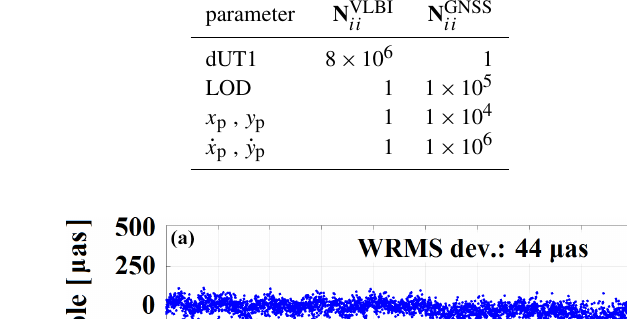
Table 4. Ratio N VLBI values in 2018).